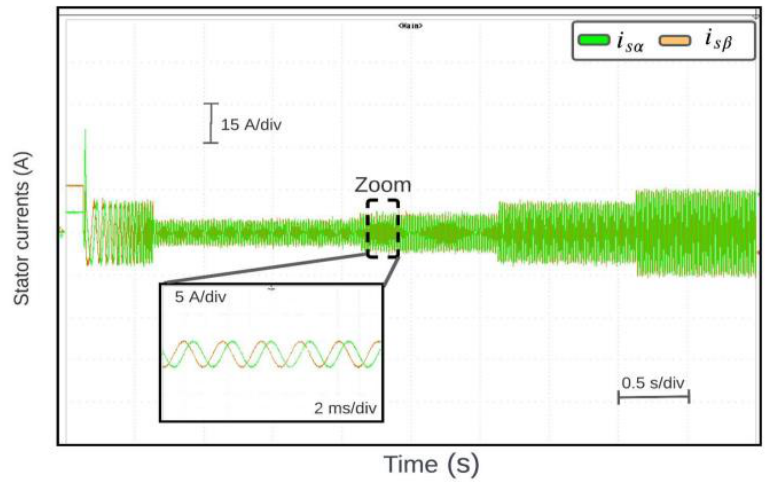
Figure 8. The stator currents in α - β frames.